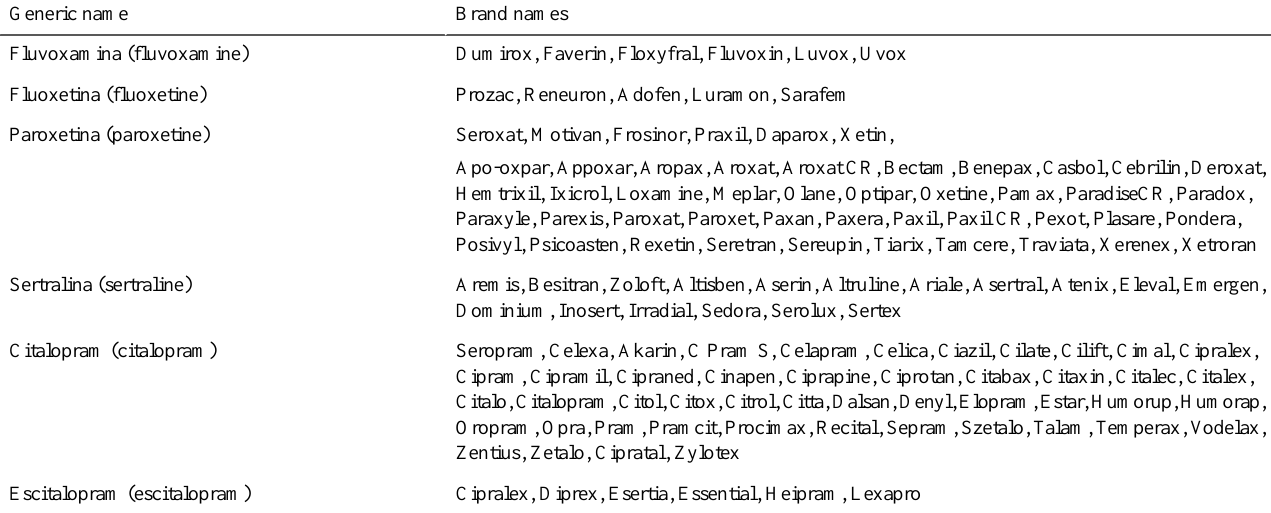
Brand namesGeneric